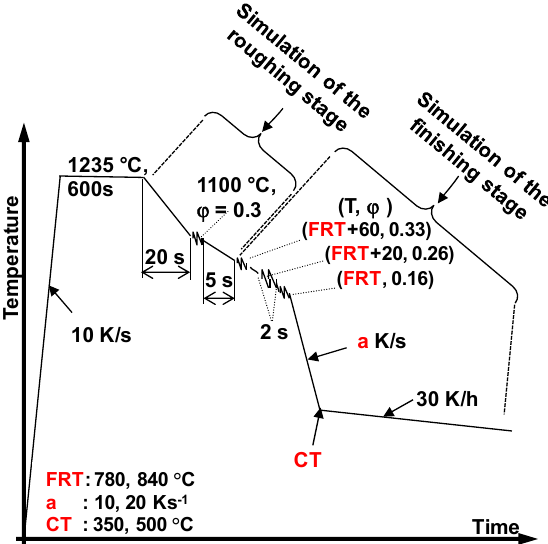
Figure 2. Schematic of the applied TMP.